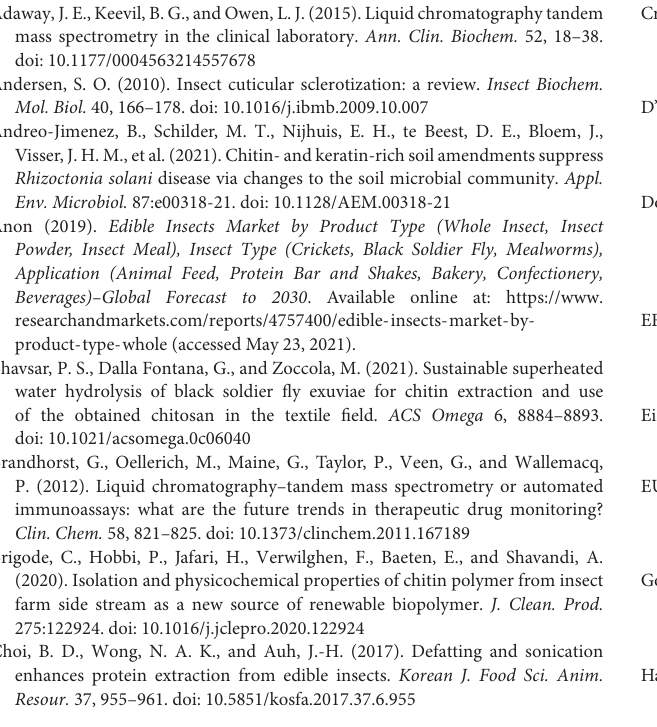
Supplementary Figure 1 | The final product of the chitin extraction procedure (left to right: pure commercial chitin, mealworm exuviae, BSF adult, BSF puparium, BSF larval exuviae, cricket exuviae).